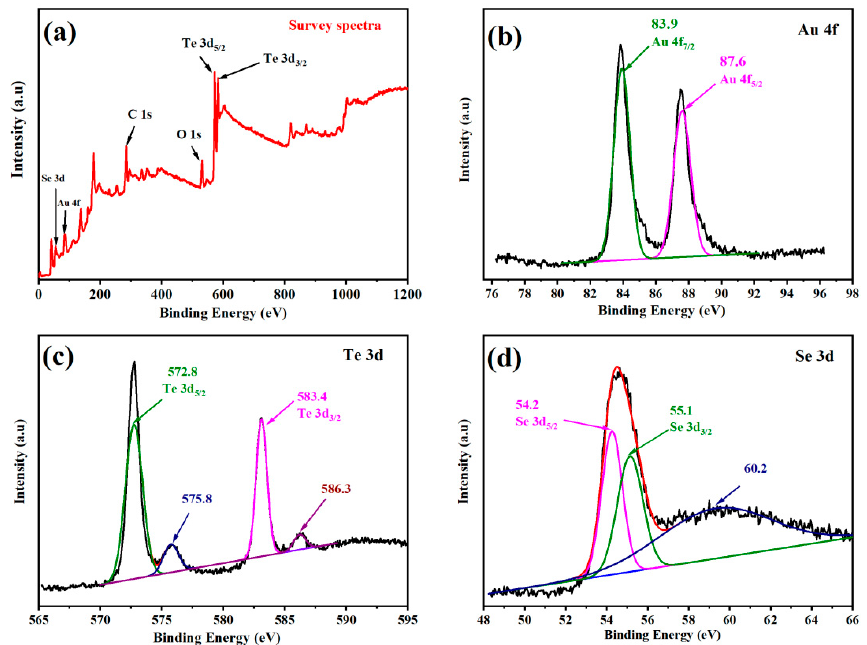
Figure 3. XPS spectral patterns of the Se-Te@Au composite showing full ( a ) and deconvoluted spectra of ( b ) Au 4f, ( c ) Te 3d, and ( d ) Se 3d, respectively